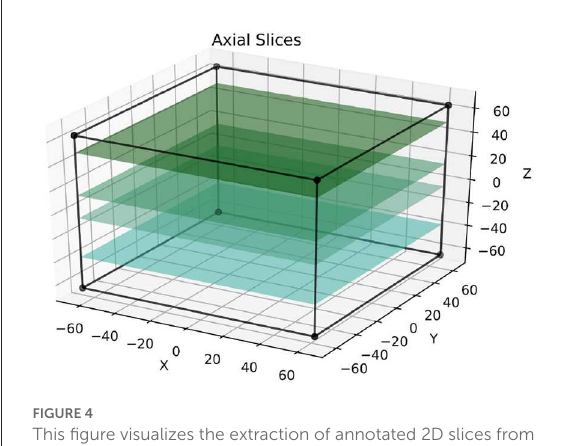
FIGURE4 This figure visualizes the extraction of annotated 2D slices from a 3D volume, where colored slices correspond to labeled data. The approach is referred to as axial following the terminology used in radiology. The sizes of the cuboids are true to the real training patches.